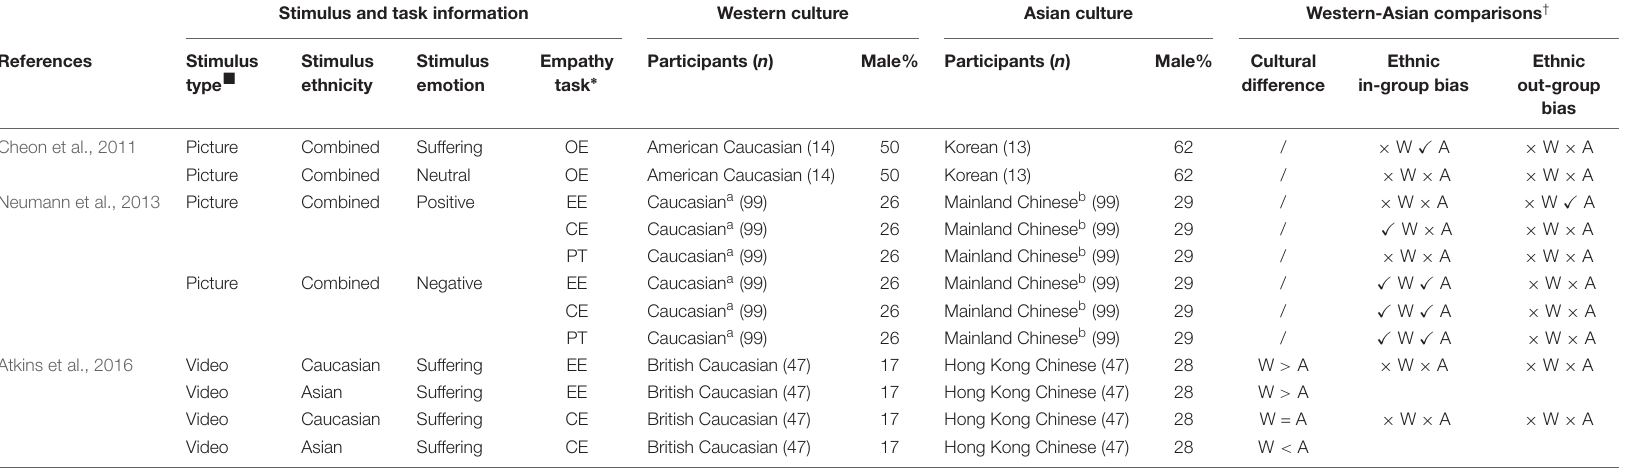
TABLE 2 | A literature review of Western-Asian cross-cultural comparisons of state empathy using computer-based tasks.